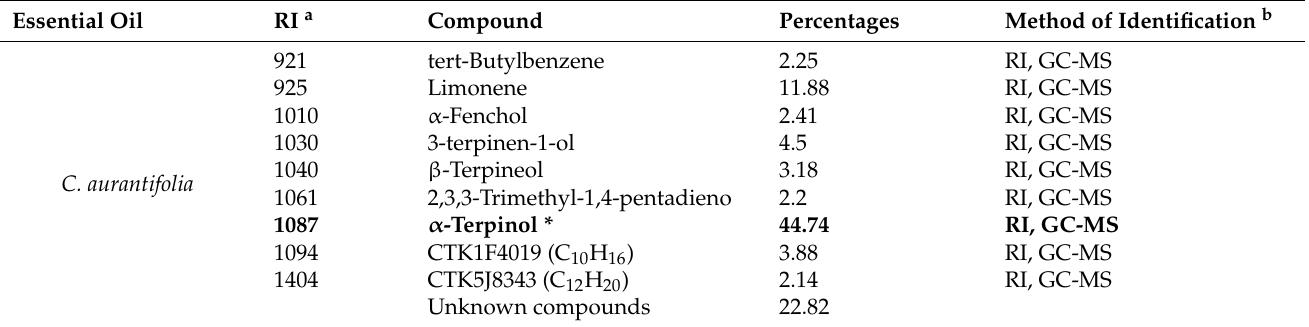
Table 1. Chemical profile of Citrus aurantifolia , Citrus aurantium and Citrus aurantium bergamia using gas chromatography coupled with mass